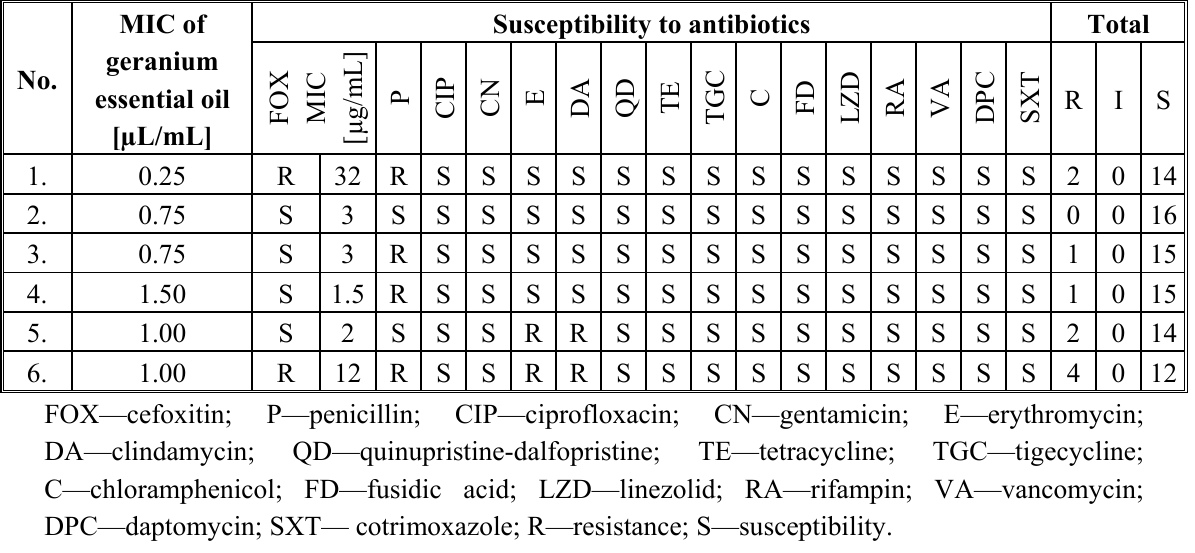
Table 6. Characteristics of S. aureus strains isolated from the conjunctival